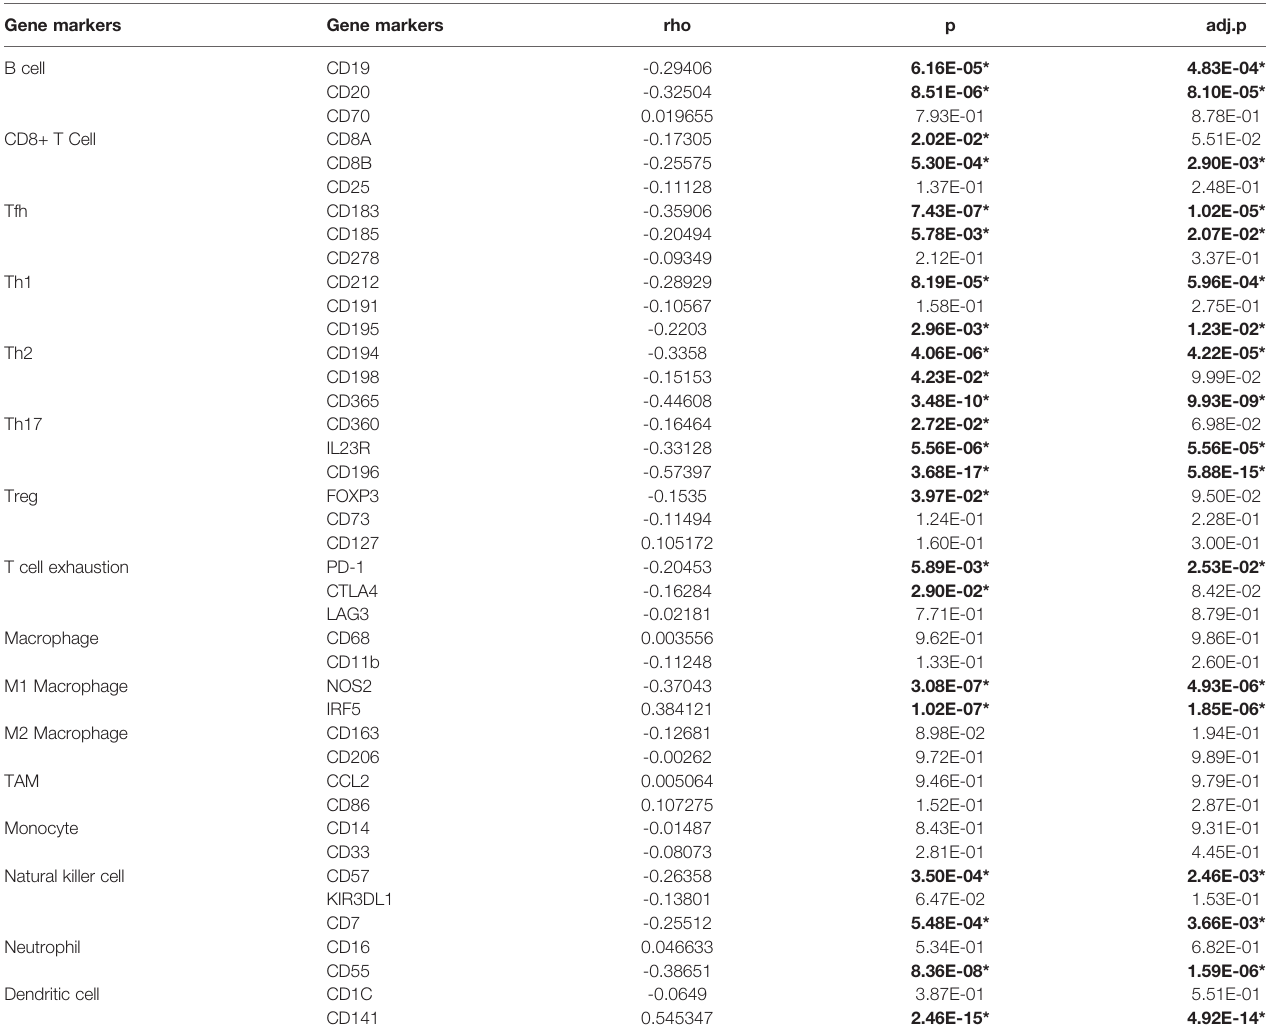
TABLE 2 | Correlation analysis between GLUT1 and relate genes and markers of immune cells in TIMER. Gene markers Gene